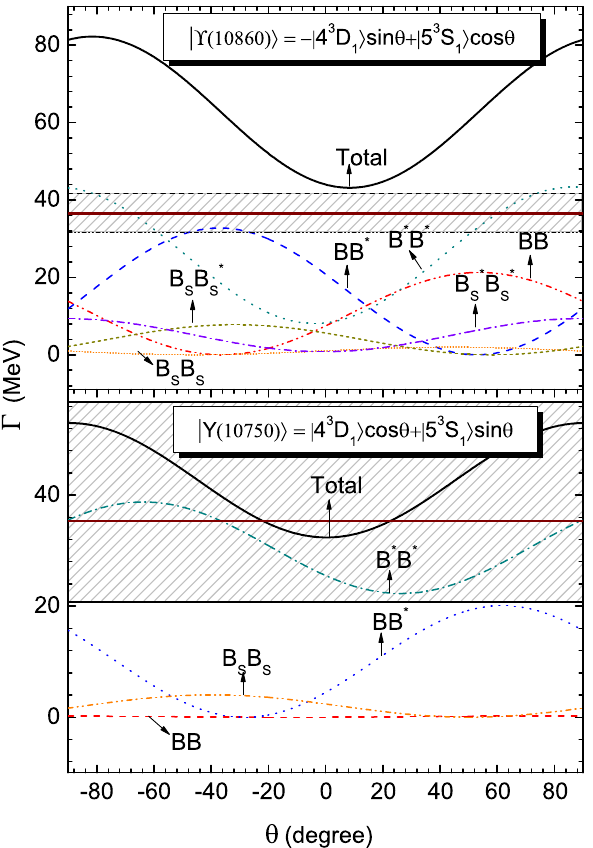
Fig. 2 Strong decays of Y ( 10750 ) and ϒ( 10860 ) versus the mixing angle θ withinscreenedpotentialmodel.Thehorizontallineisthecenter valueoftheexperiment,andtheshadedregionrepresentstheerrorrange of the experiment